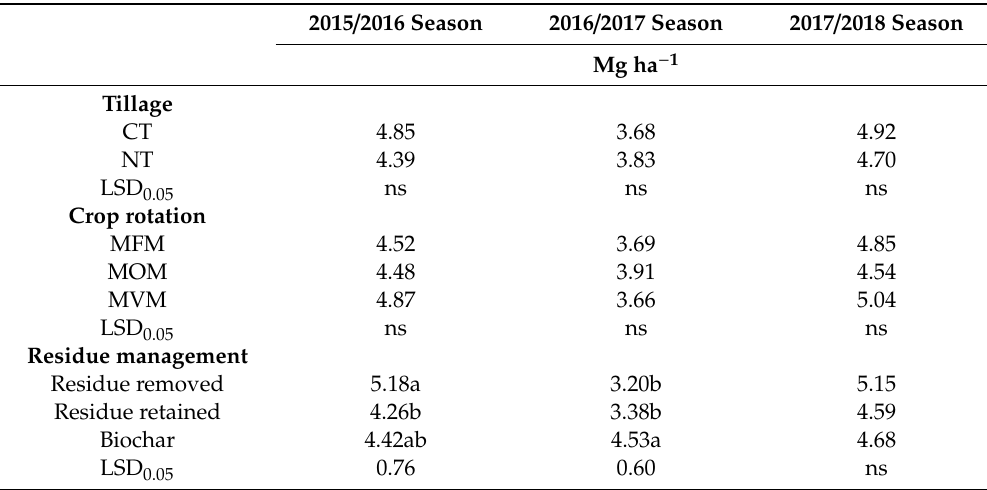
Table 5. Season, tillage, crop rotation, and residue management e ff ects on the maize grain yield recorded during the 2015 / 2016, 2016 / 2017 and 2017 / 2018 summer seasons at the University of Fort Hare research